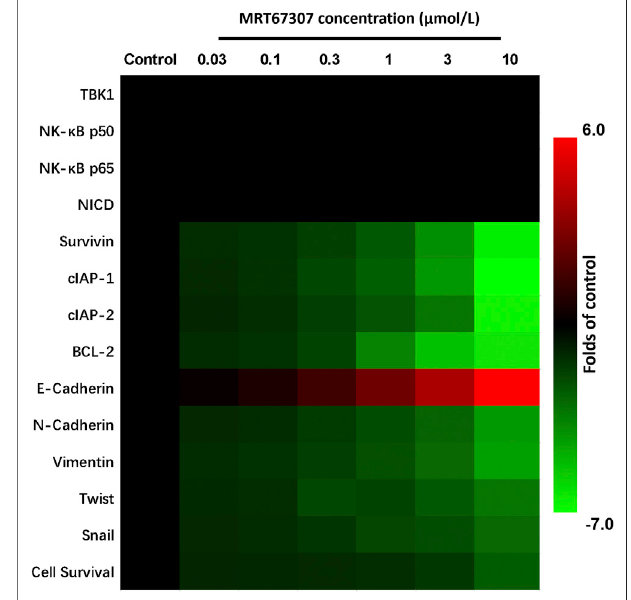
FIGURE 7 | The effect of TBK1 ’ s inhibitor MRT67307 on the drug- resistance-relatedfactorsinHCCcells.MHCC97-Hcellsweretreatedwiththe indicated concentration of MRT67307 and the expression level of drug- resistance-related factors were examined by qPCR. The inhibitory activationofMRT67307onMHCC97-HcellswasexaminedbyMTTmethods. The results are shown as heat-map.